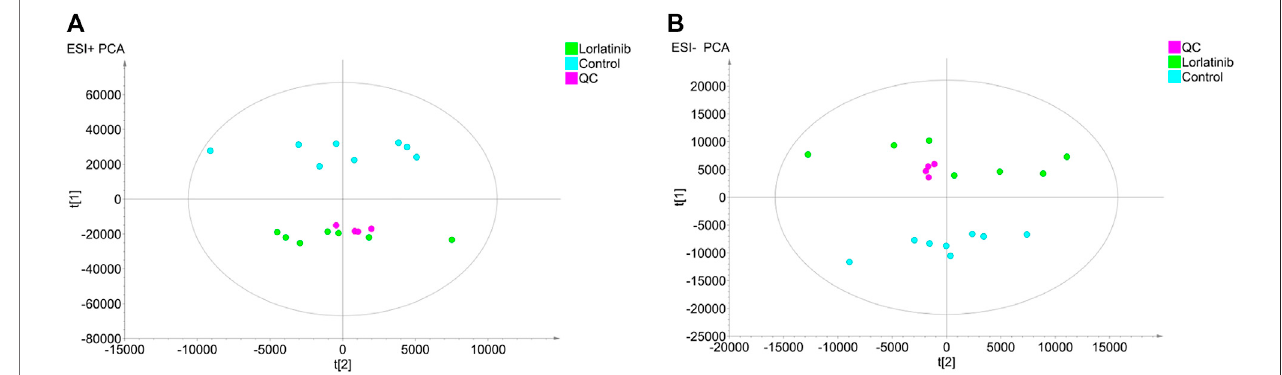
FIGURE 1 | Principal component analysis (PCA) score plots obtained from the lorlatinib and control groups in positive (A) and negative (B) electrospray ionization source (ESI) mode.